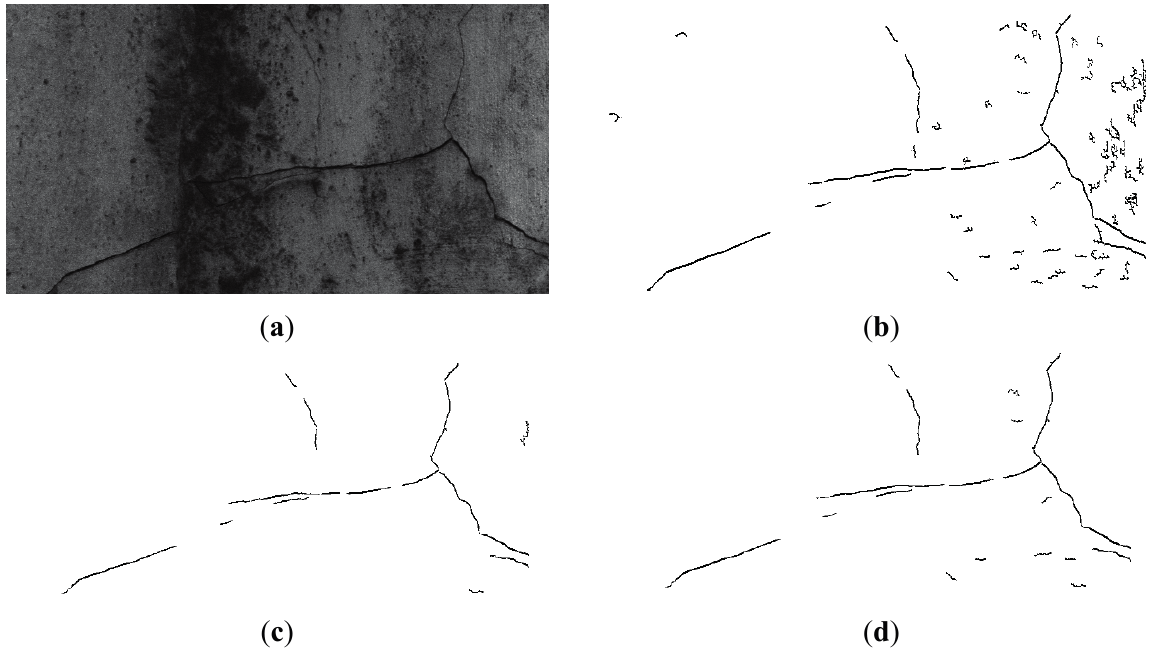
Figure 8. Example of the classified cracks, in which ( a ) represents the original image; ( b ) the detected cracks before classification; ( c ) the classification results by ELM; and ( d ) the classification result by thresholding